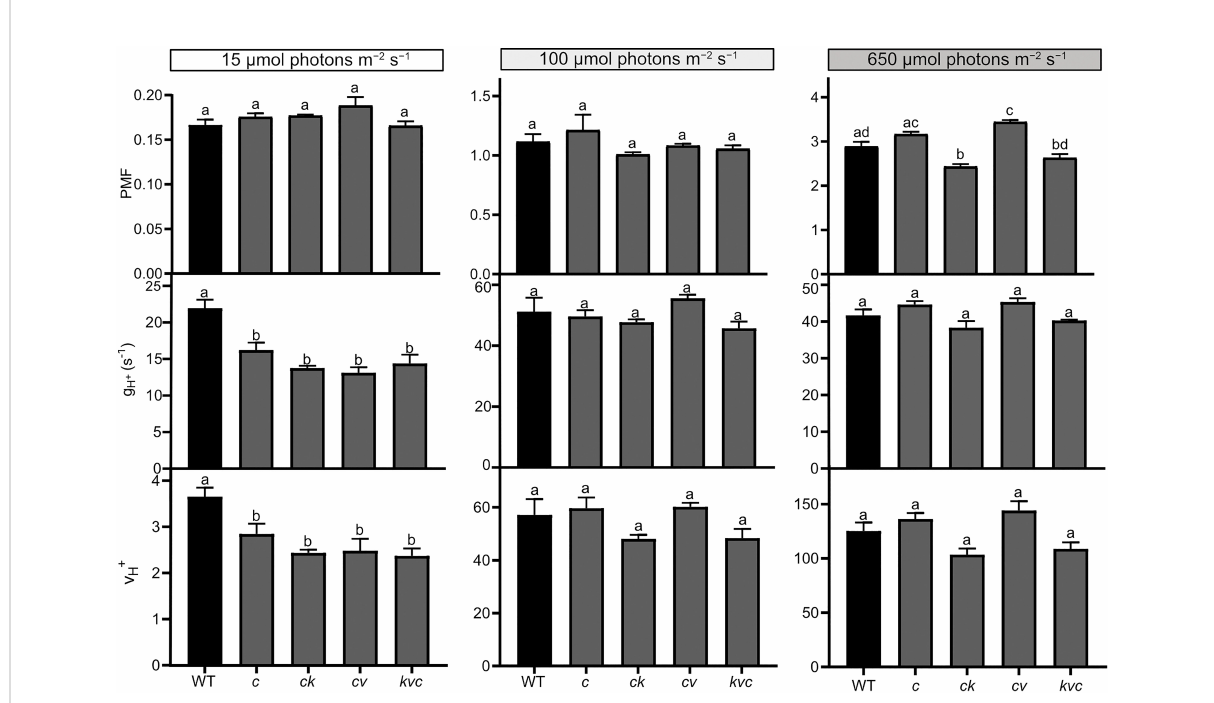
FIGURE 5 Steady-state proton motive force, H + conductivity and H + fl ux through the ATP synthase. Electrochromic shift measurements (ECS) were performed on 30 min dark-acclimated wild-type (WT) and mutant plants grown in short-day conditions (120 µmol photons m − 2 s − 1 ) and illuminated for 15 min at the indicated intensities. Total proton motive force (PMF), ATP synthase H + conductivity (g H+ ) and H + fl ux (v H+ ) were calculated from ECS decay kinetics as described in Methods. The plotted data were obtained from Figure 4 and represent means ± S.E.M. ( n = 6 plants). WT – Col-0 , c – clce-2 , k – kea3-1 , v – vccn1-1 , and kvc – kea3-1vccn1-1clce-2. Different letters denote statistically signi fi cant differences among genotypes according to ANOVA ( P <